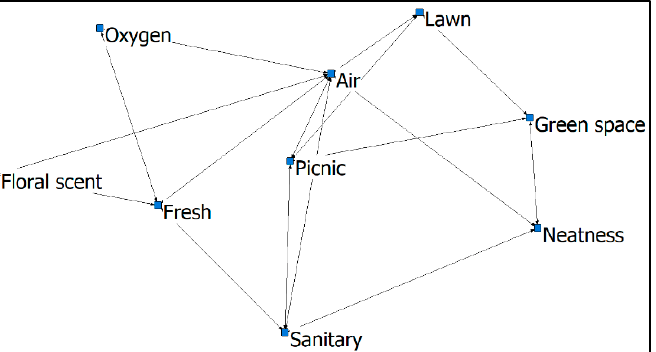
Figure 9. 1-3. Visual and olfactory interactive experience during outdoor activities.